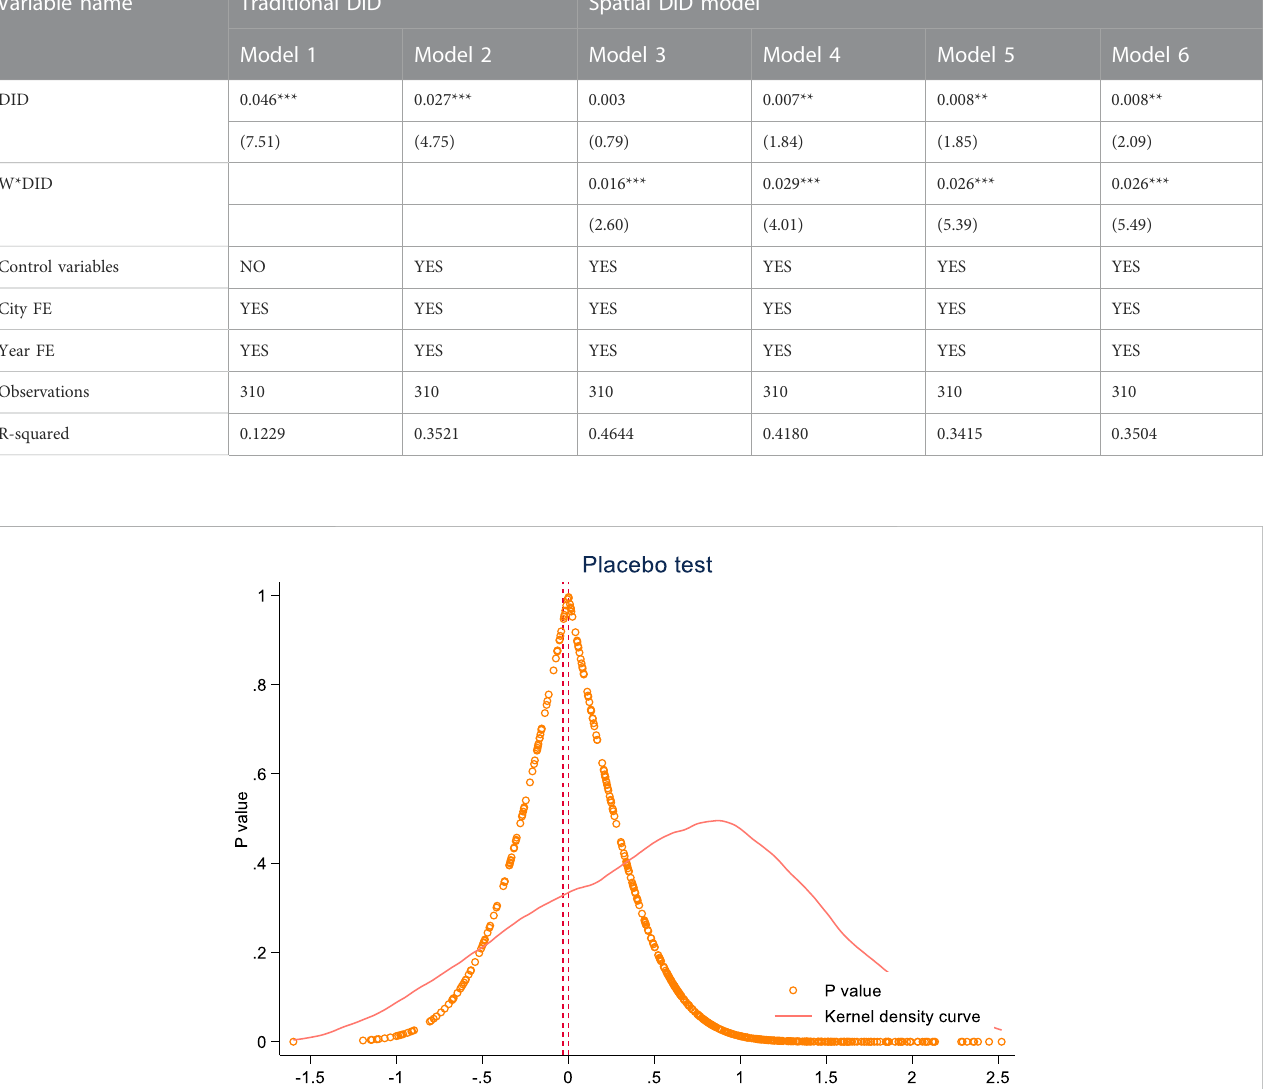
FIGURE 3 Placebo test